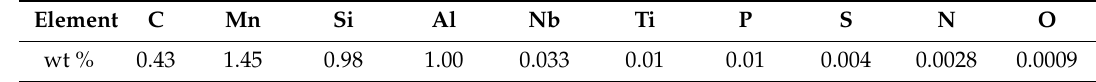
Table 1. Chemical composition of the investigated steel.